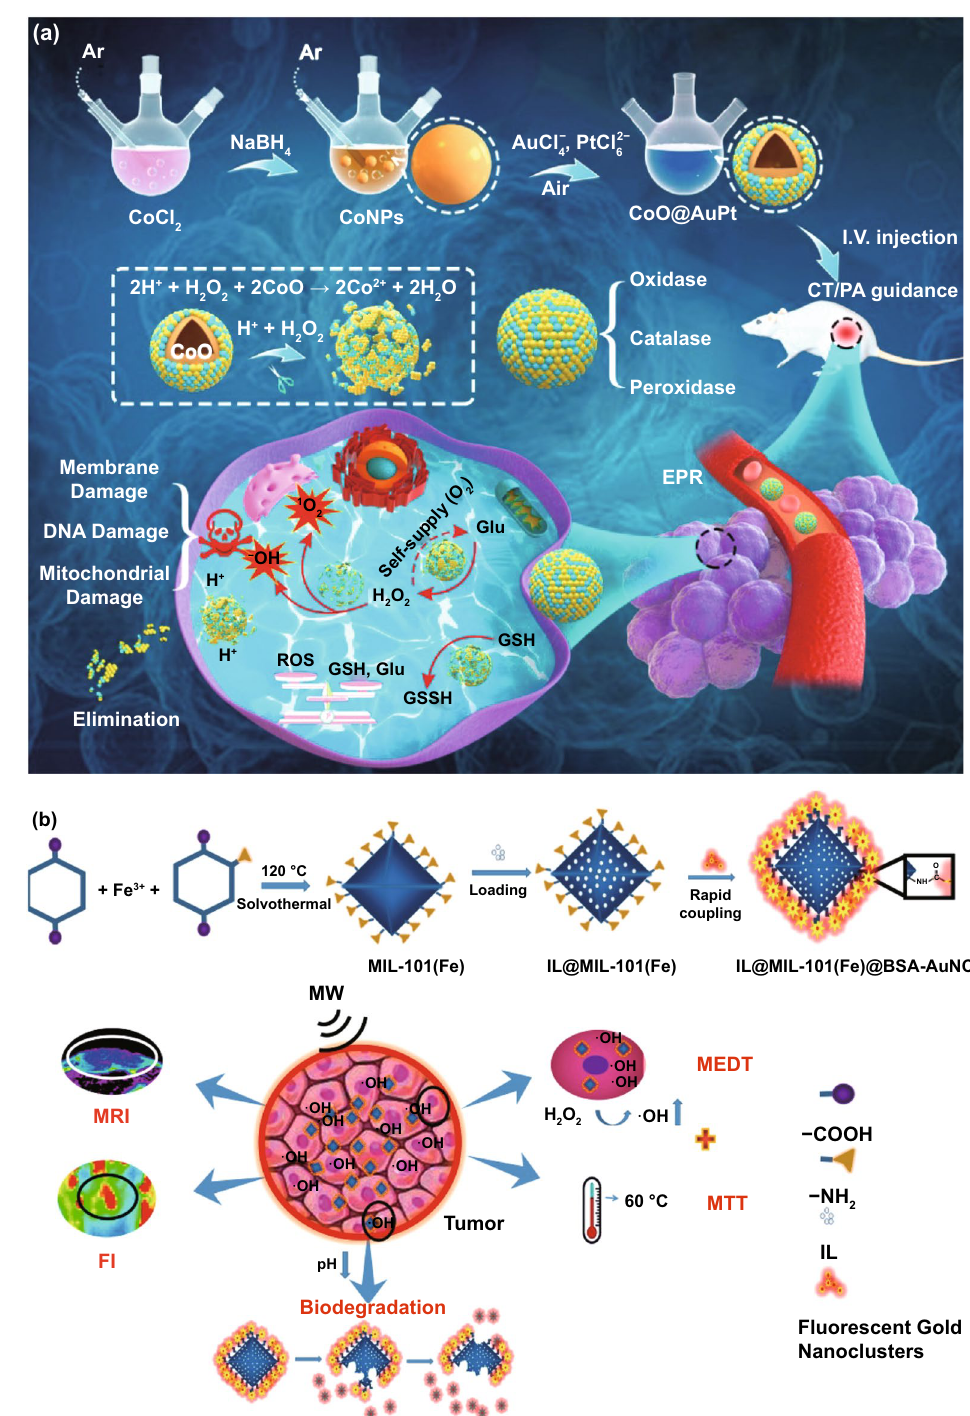
Fig. 12 a Preparation and the catalytic mechanism for CDT enhancement of CoO@AuPt NPs via Fenton reactions and regulating the response environment. b Preparation, the degradation process and the therapy principle of IL@MIL-101(Fe)@BSA-AuNCs NPs for MEDT. GSSH Glu- tathione disulfide, EPR enhanced permeation and retention, MW microwave, MRI magnetic resonance imaging, MTT microwave thermal ther- apy, FI fluorescence imaging. Adapted from a Ref. [426], b Ref. [131] with